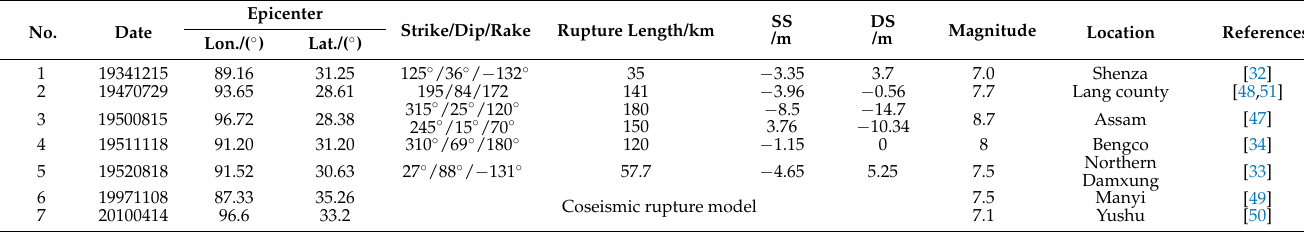
Table 2. Source rupture model parameters of strong historical